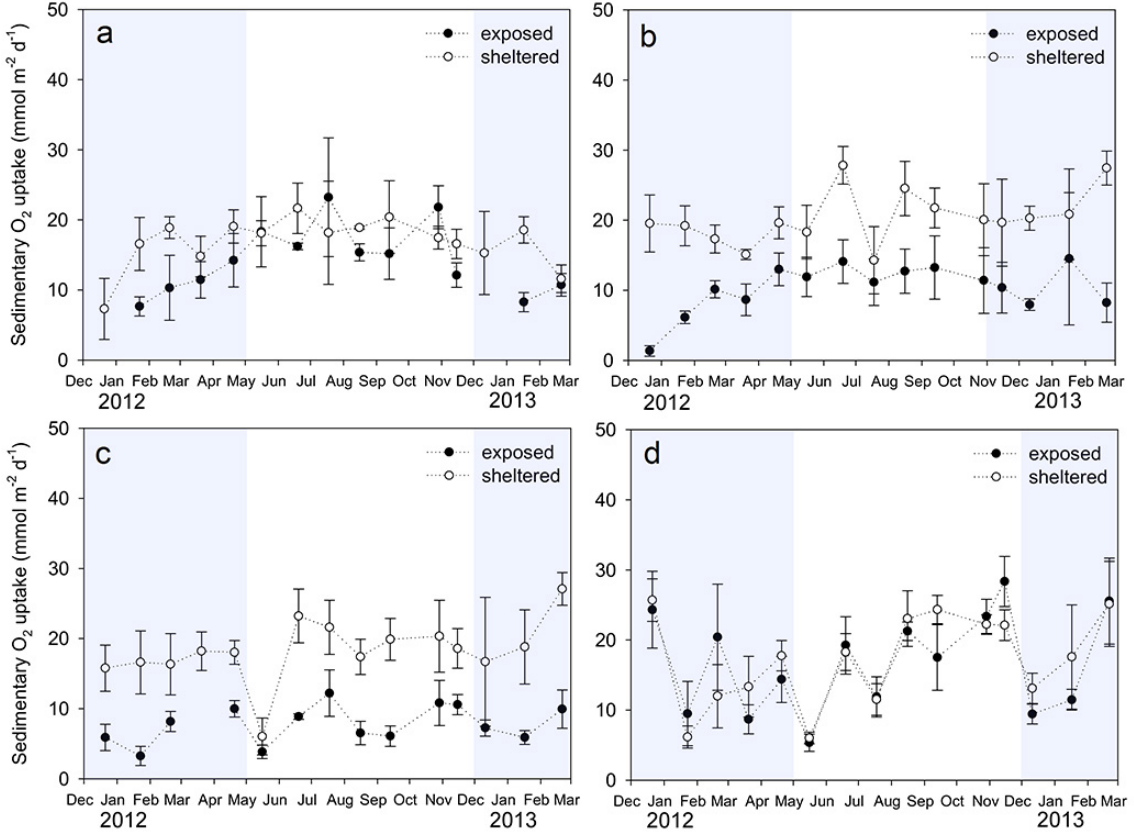
Figure 4. Sedimentary O 2 uptake in Tayrona National Natural Park. Displayed are sedimentary O 2 demand rates at an exposed site and a sheltered site in the bays (a) Chengue; (b) Gayraca; (c) Neguanje; and (d) Cinto. Major upwelling periods are highlighted in